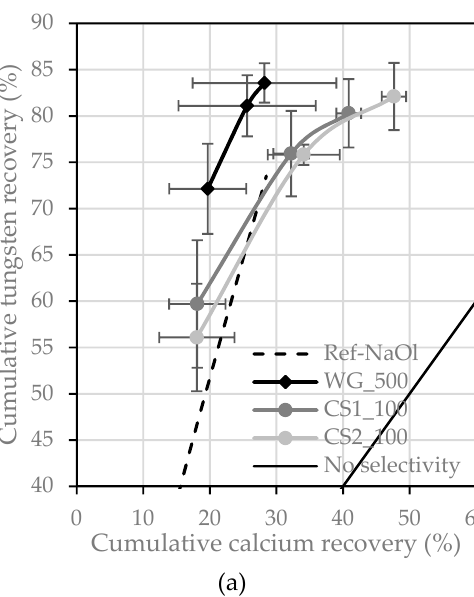
Figure 3. ( a ) Mass pull against water pull and ( b ) cumulative tungsten grade against recovery (error bars represent the 95% confidence interval).